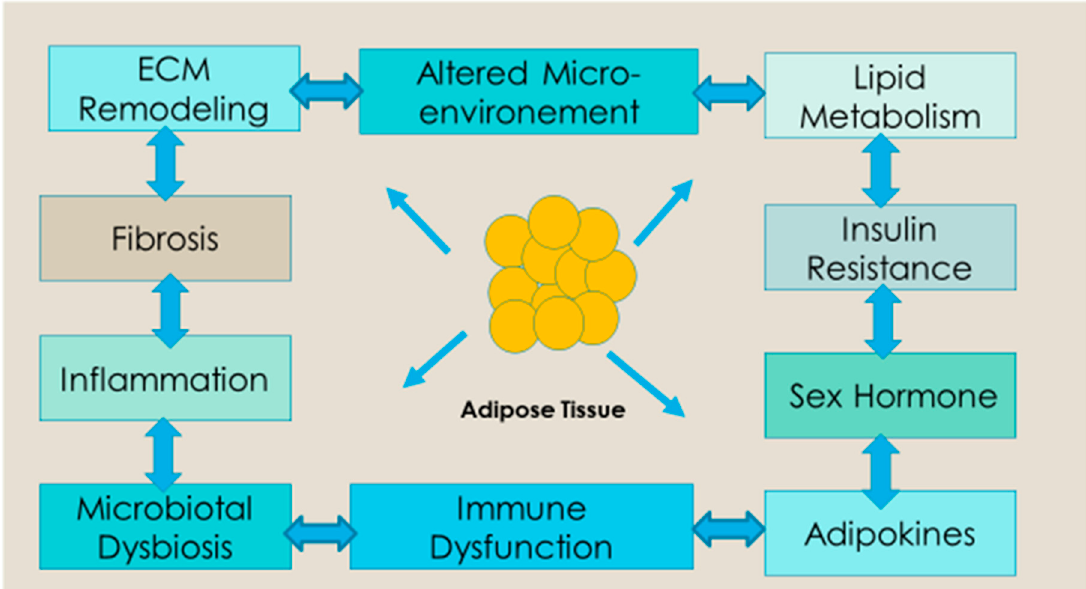
Figure 1. Potential mechanism of obesity-induced dysfunction of adipose tissue on tumor initiation, progression, and recurrence. Excess fat accumulation results in dysfunction of adipose tissue that causes increased production of proinflammatory cytokines, sex hormones, and lipid metabolites, along with impaired adipocyte-derived cytokines or adipokines profiles and insulin resistance. The altered adipose tissue is a source of ECM remodeling, fibrosis, cancer-associated adipocytes, impaired microbial metabolism, adipocyte progenitors, inflammation, and altered micro-environment. These factors contribute to tumor initiation, growth, and recurrence.